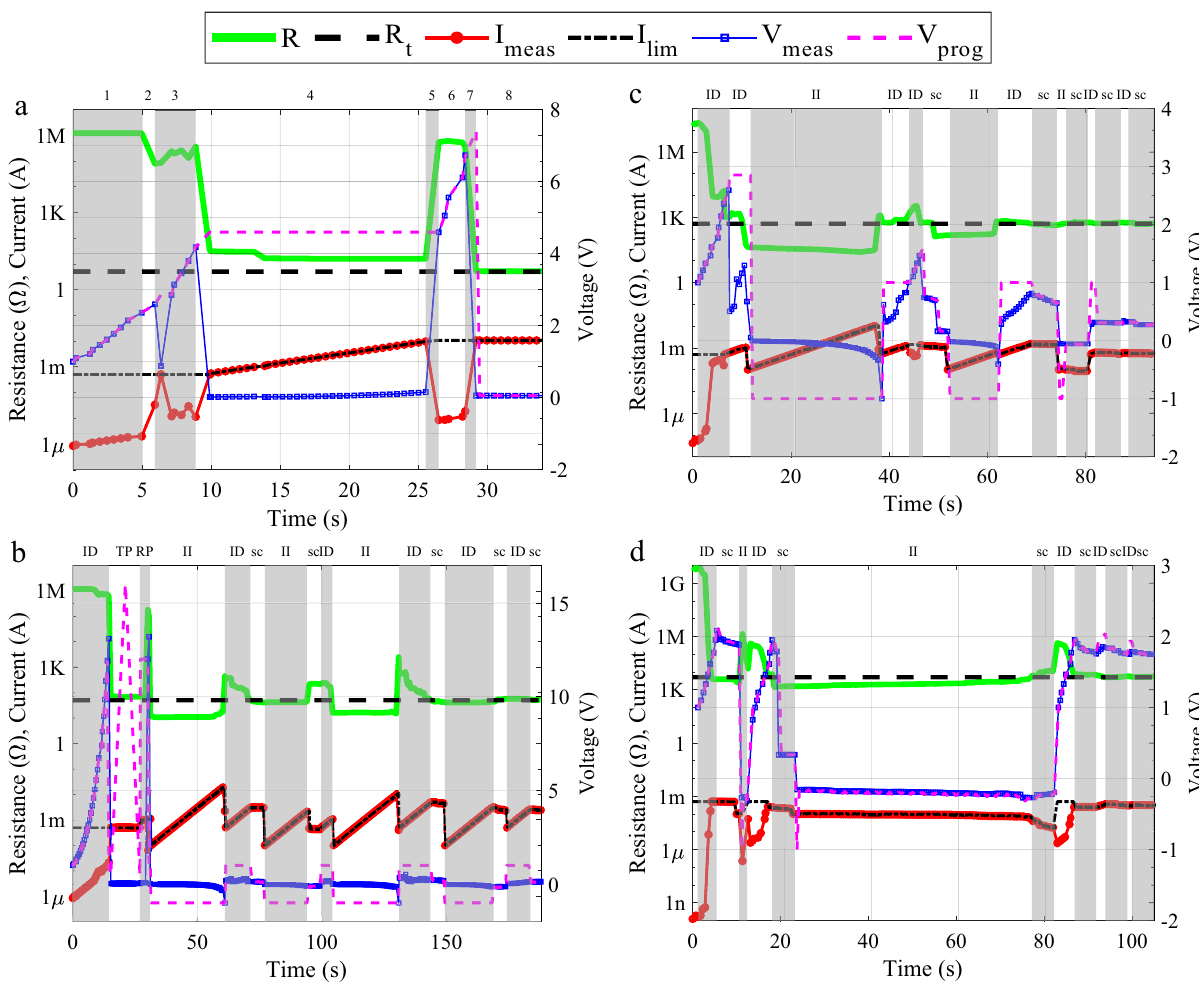
Figure 3. Resistance programming algorithm runs on four different cells. ( a ) Rt = 5 Ω. ( b ) Rt = 50 Ω. ( c ) Rt = 500 Ω. ( d ) Rt = 5000 Ω. In these experiments TP sweep rate was set to 2.8 V/s, RP pulse width was 5 s, II and ID pulse width were set to 0.68